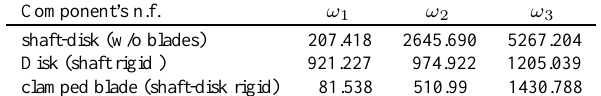
Table 2 Natural frequencies (Hz) of shaft-disk, disk and clamped blade Component’s